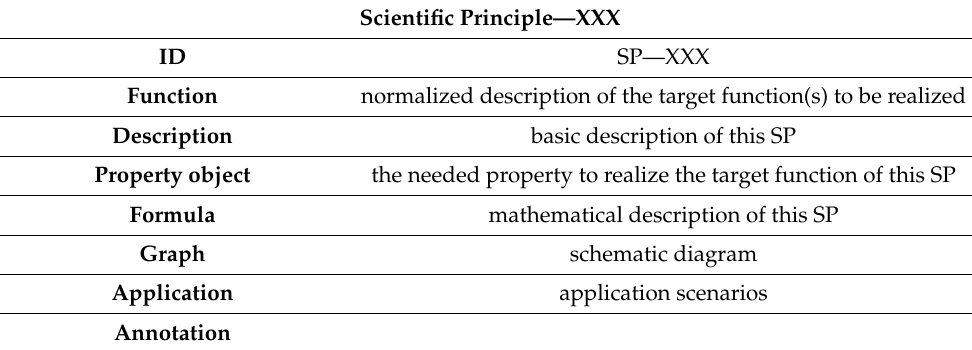
Table 1. The representation template of scientific